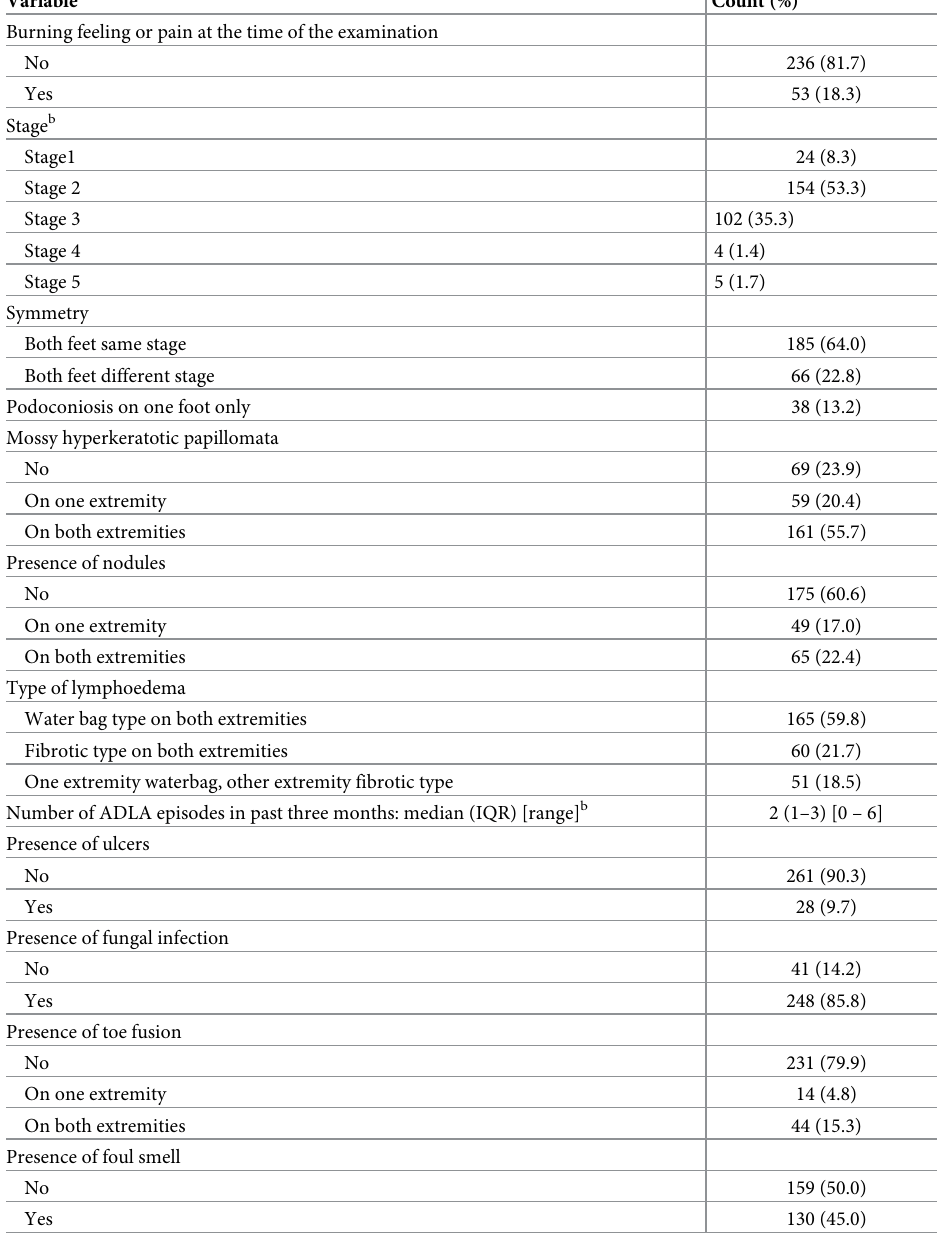
Table 2. Clinical features of patients with podoconiosis in Durbete Podoconiosis Prevention and Treatment Cen- ter, Durbete, Ethiopia, February 2018 to October 2019 (n = 289).